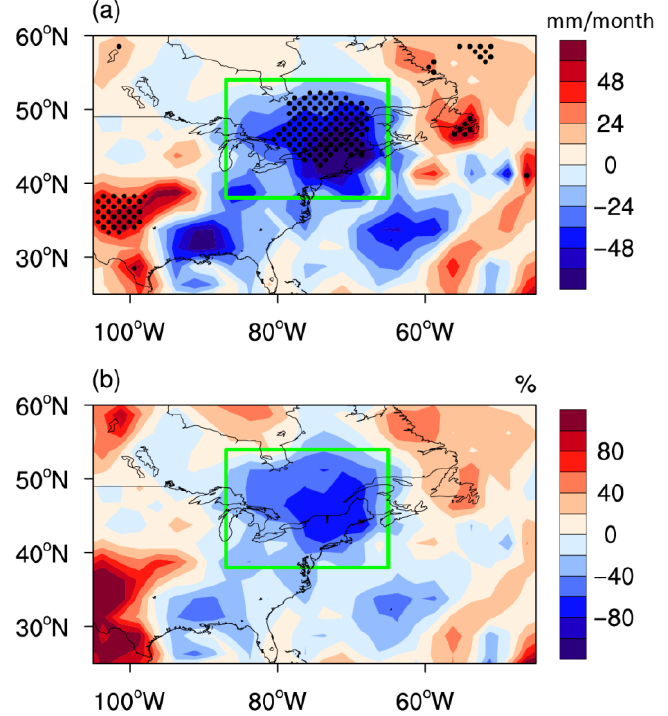
Table 1. Positive and negative ASO anomaly events during the period 1985 – 2019. A positive (neg- ative) ASO anomaly event is identified when the March ASO index, calculated from SWOOSH, is greater (smaller) than 1 (−1) standard deviation.